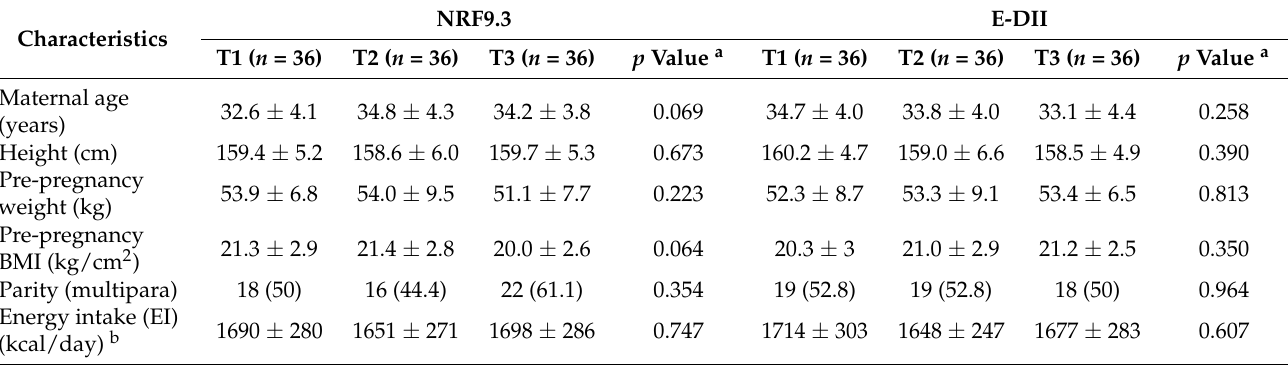
Table 1. Characteristics of the Japanese pregnant women across the tertile (T) categories of dietary index, BC-GENIST